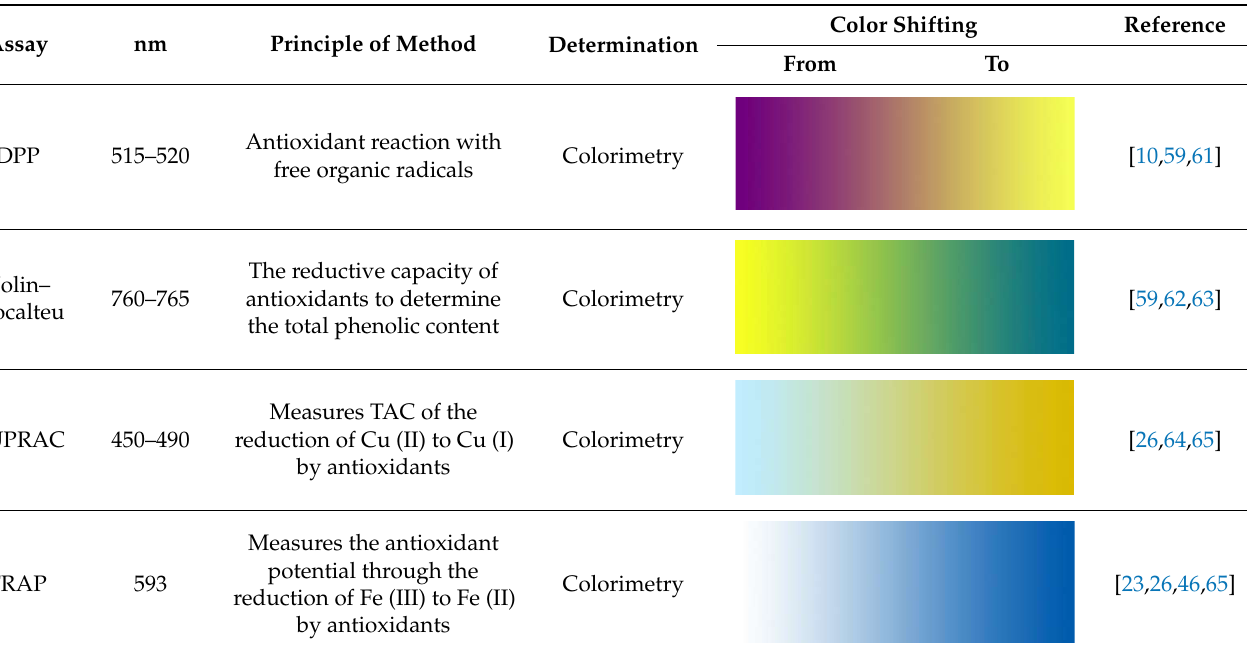
Table 2. Spectrophotometric parameters of each assay.